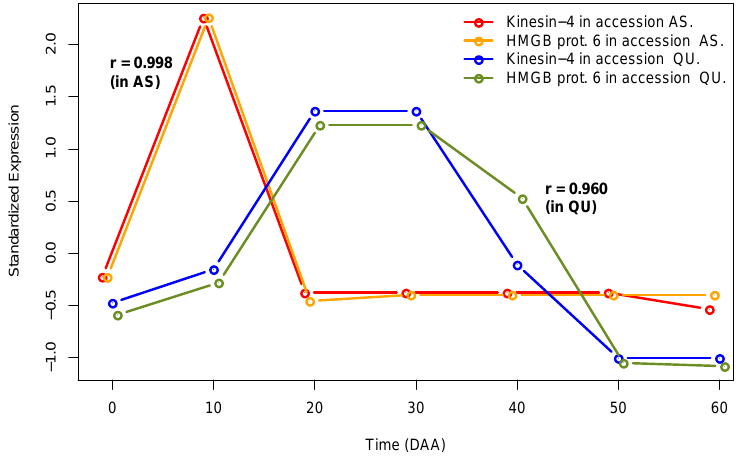
Figure 1. Example of SEPs for two highly correlated genes in two independent